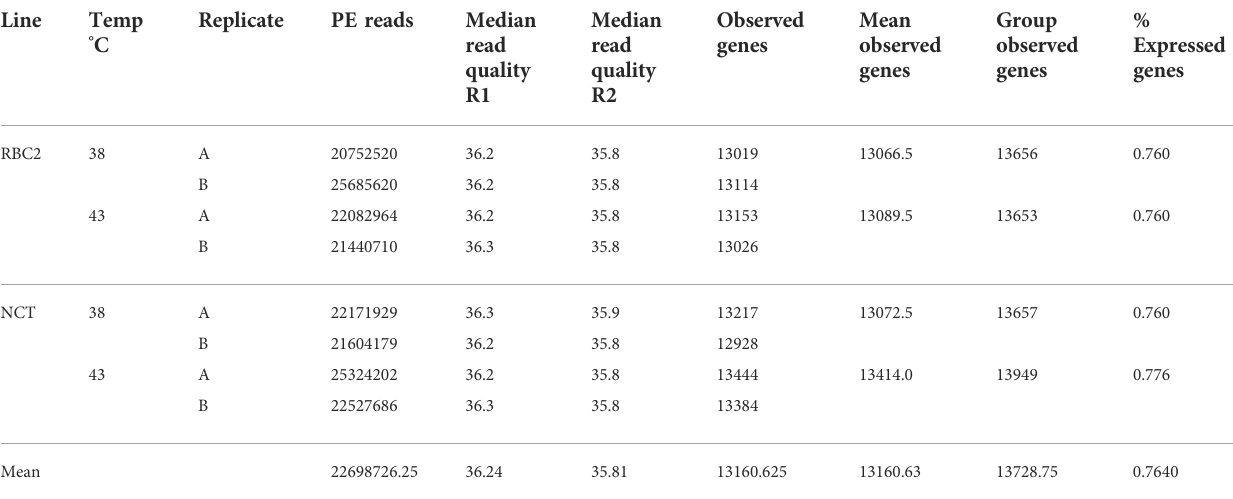
TABLE 1 Summary of RNAseq data for proliferation experiment.For each library the total number of raw reads, median read qualities (R1 and R2), the number of observed genes (mapped reads > 1) by library and treatment group and the percentage of expressed genes (group read count > 1.0) are given.